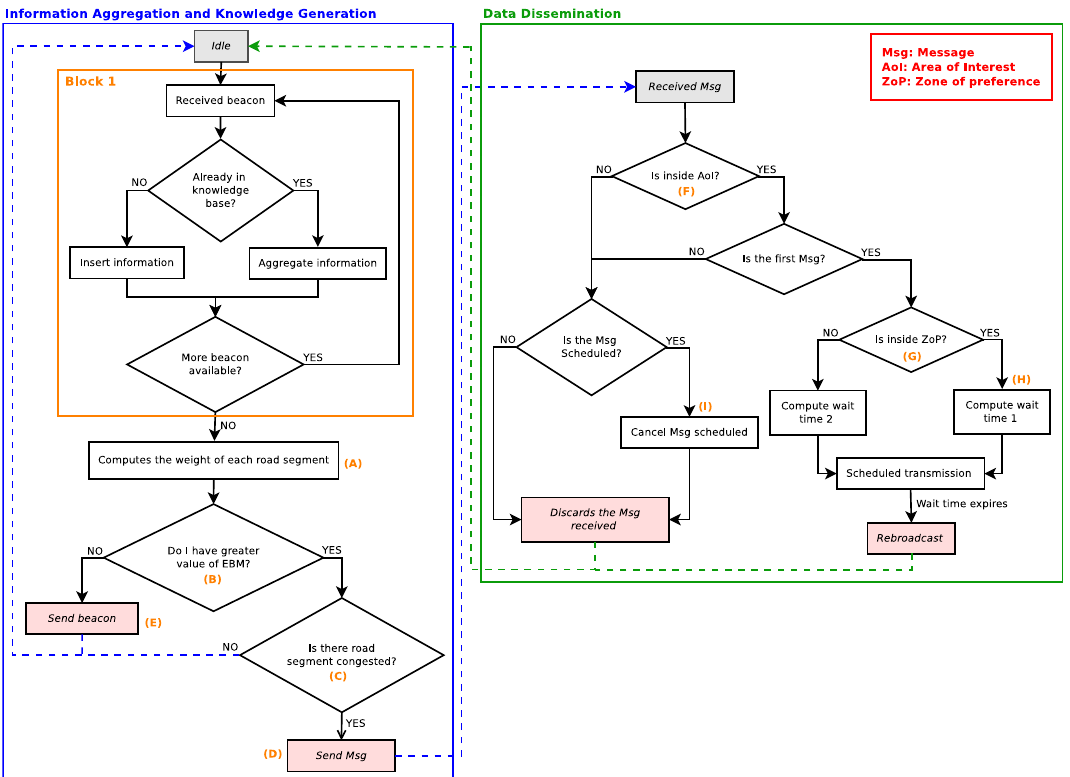
Figure 16. Operation flowchart of the proposed